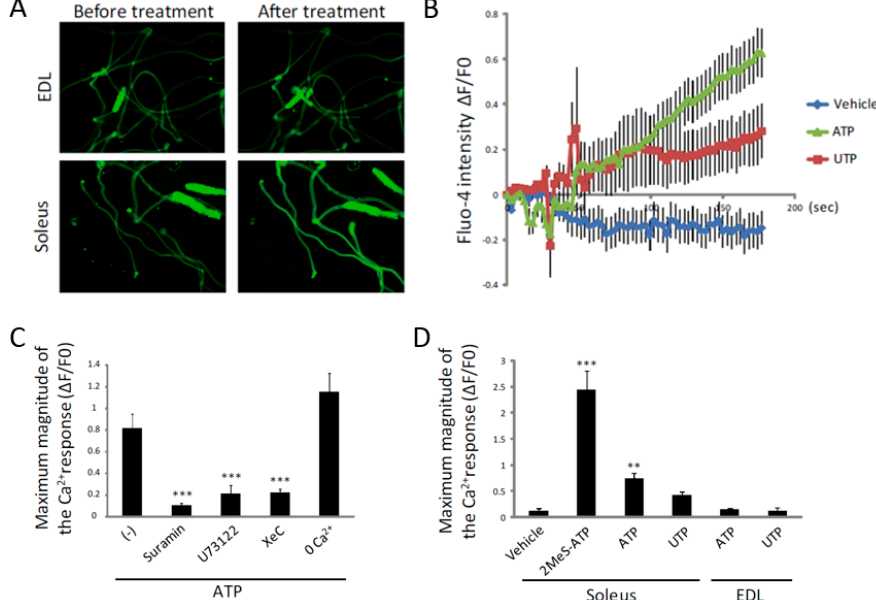
Figure 5. ATP induces an increase in [Ca 2+ ] i by the activation of the P2Y receptor and its downstream PLC/IP 3 R pathway in single fibers isolated from soleus muscle. ( A ) Representative fluorescence imaging of Fluo-4-loaded single fibers isolated from EDL (upper) and soleus (lower) muscles before and after treatment with ATP for 3 min. ( B ) Traces of Fluo-4 fluorescence in single fibers isolated from soleus muscle. ( C ) Quantitative analysis for the maximum magnitudes of Fluo-4 intensity in suramin- , U73122-, XeC- or 0 Ca 2+ -buffer-treated single fibers isolated from soleus muscle. ( D ) Quantitative analysis of the maximum Fluo-4 intensity in 2MeS-ATP-, ATP- or UTP-treated soleus or EDL single fibers at a concentration of 100 µM. At least 10 fibers were analyzed in B, C and D. ** p < 0.01, *** p < 0.001 by ANOVA with Tukey-Kramer test. Error bars indicate